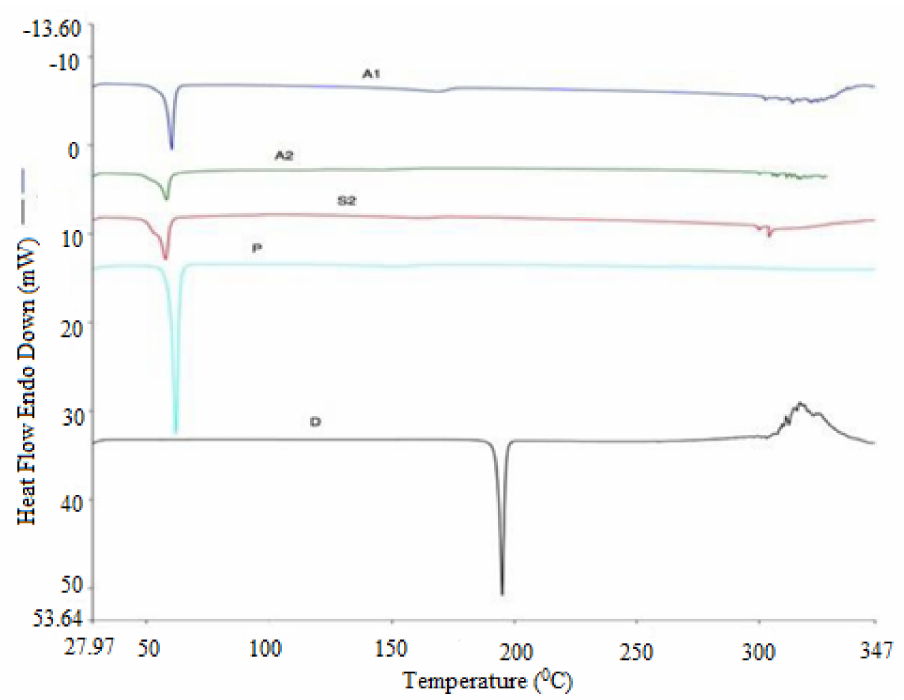
Figure 1. Differential scanning calorimetry (DSC) thermograms for pure drug (D) and various SDs prepared using fusion